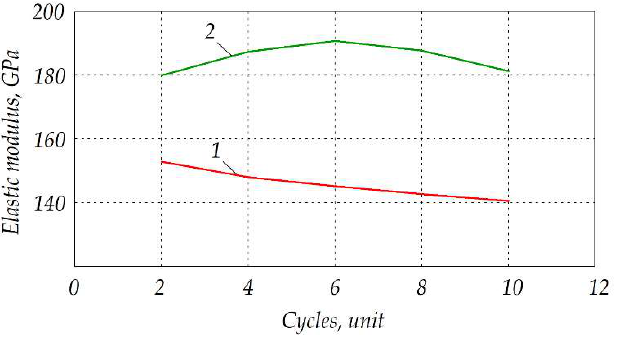
Figure 15. Elastic modulus E after heating cycles for Al 2 O 3 —20 wt.% SiO 2 —10 wt.% ZrO 2 composite samples fabricated at 1400 °С by: 1 —traditional sintering, 2 —electroconsolidation.